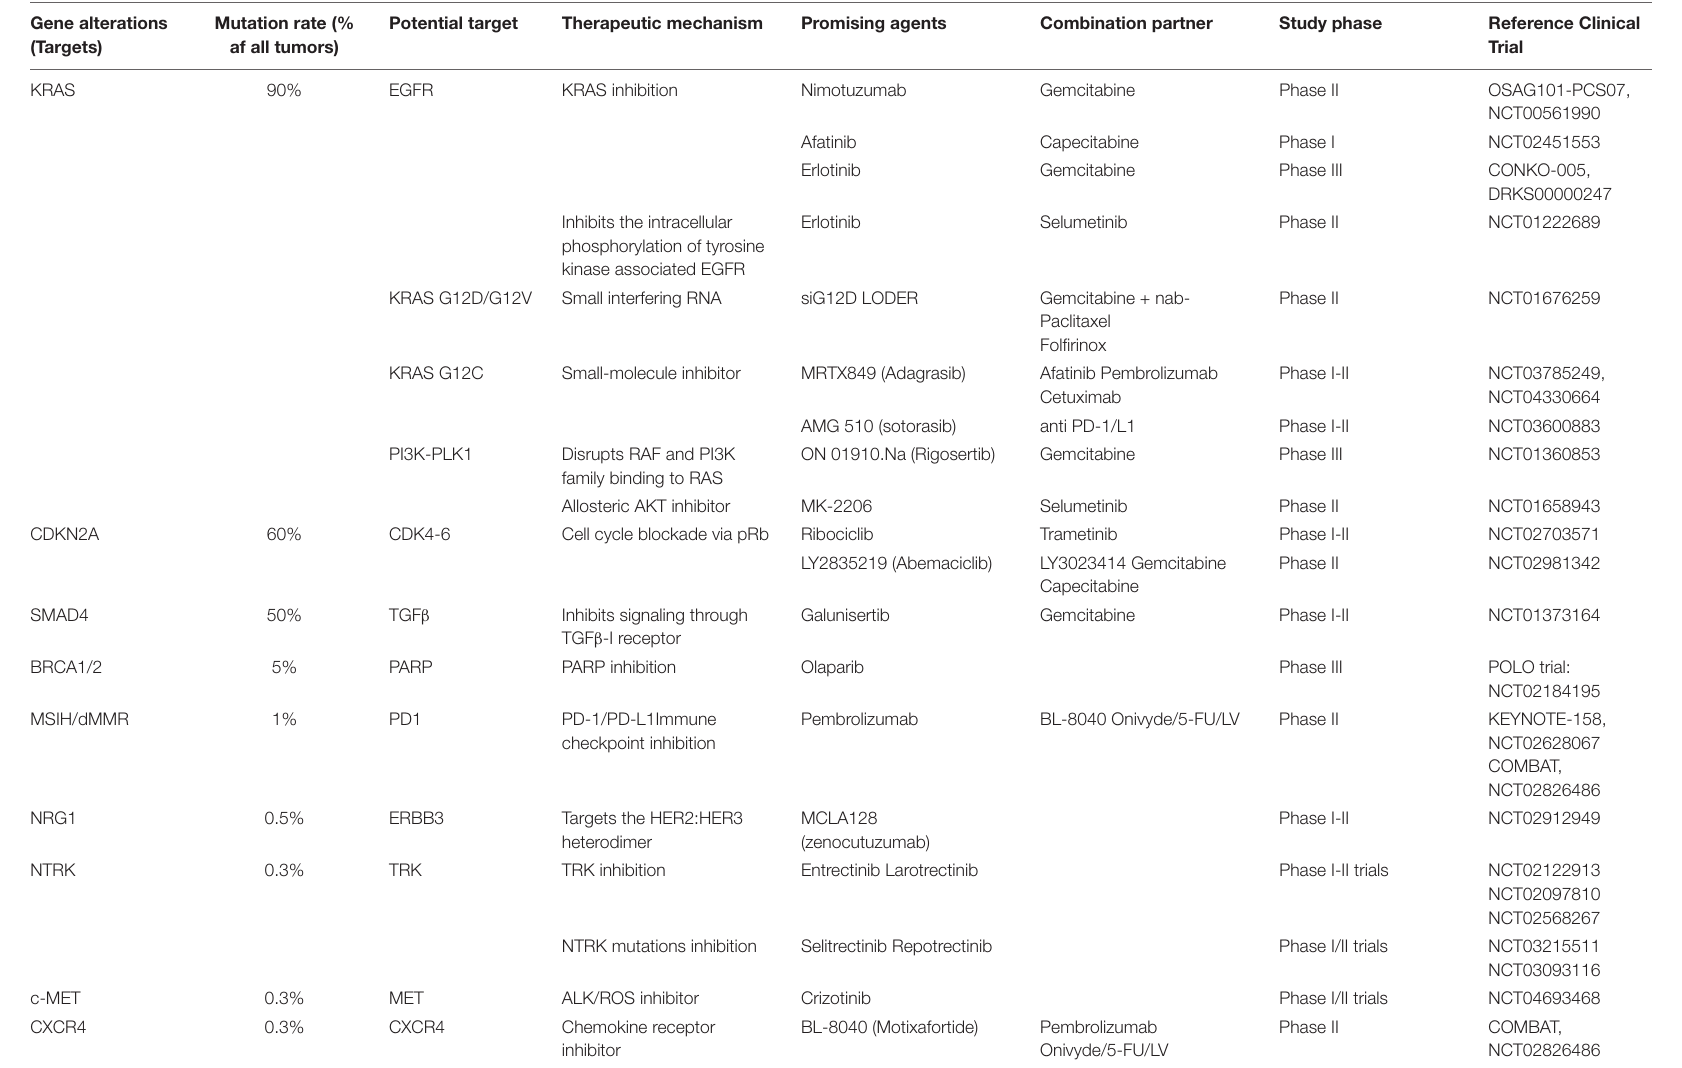
TABLE 1 | Potential therapeutic targets in PDAC undergoing Clinical